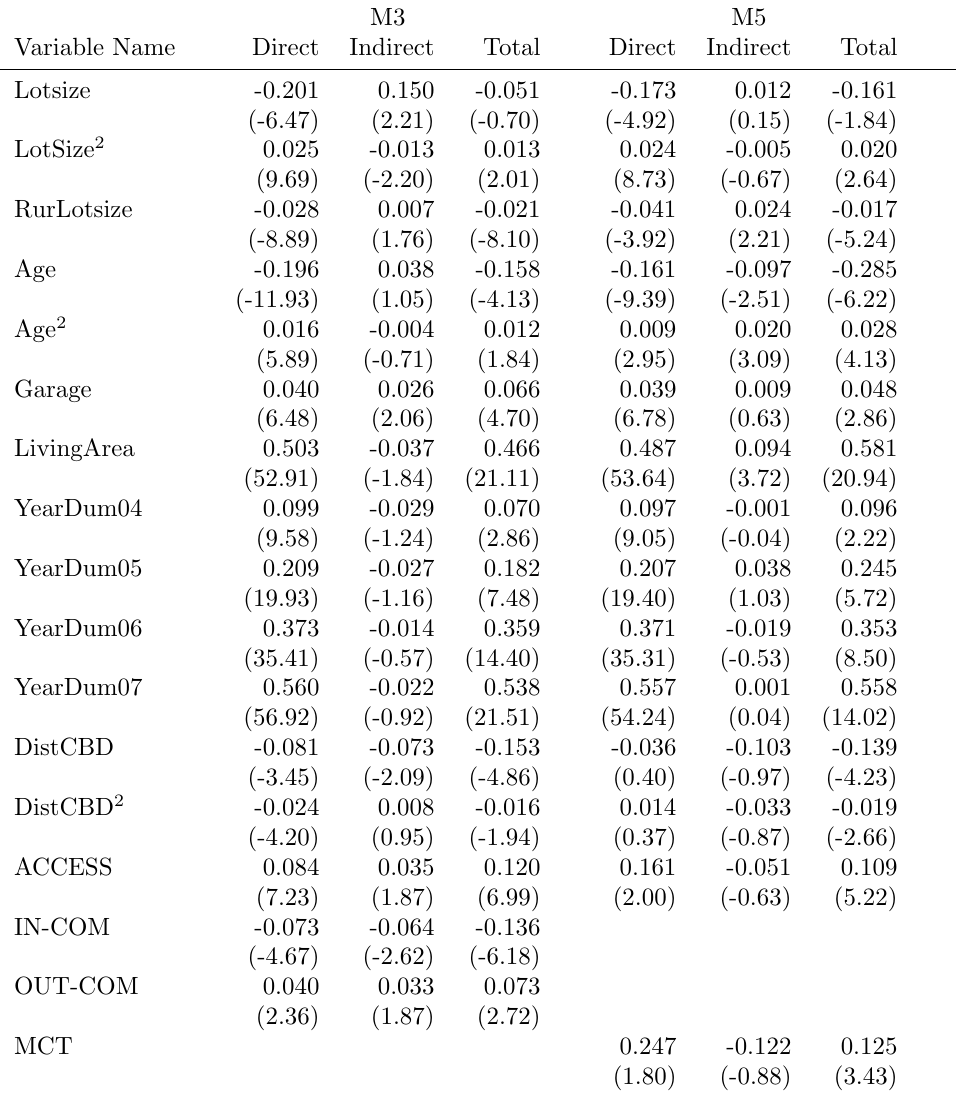
Table 3: Estimated direct, indirect, and total impact from variants of M3 and M5 using the spatial Durbin